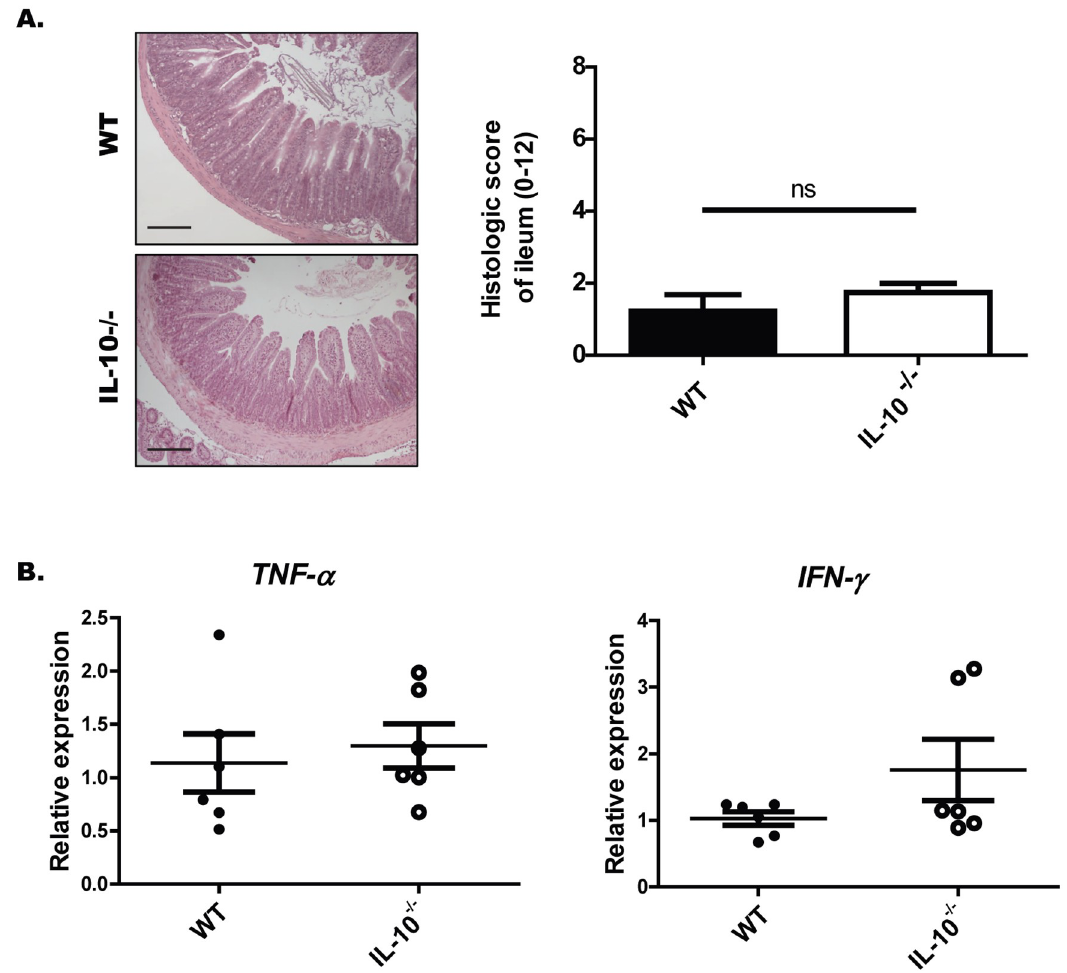
Fig 2. Seven-week-old IL-10 -/- mice do not present more signs of ileum inflammation than WT mice under SPF conditions. (A) Histopathological analysis of ileum sections of wild-type and IL-10 -/- mice. Left panel: Representative images of ileum sections stained with H&E (Scale bars are 200 μ m). Right panel: Histologic score. (B) Relative expression of TNF- α and IFN- γ in ileum sections of WT (n = 5) and IL-10 -/- (n = 6)